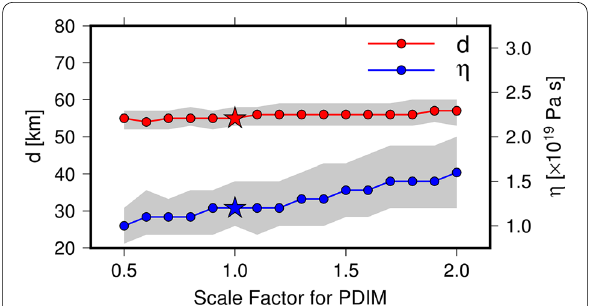
Fig. 12 Variation in the optimal values of the rheological parameters when the scale factor for PDIM is changed from 0.5 to 2.0. Red and blue lines indicate the optimal lithospheric thickness ( d ) and the upper mantle viscosity ( η ), respectively, and their error ranges are shown as the gray areas. The stars indicate the optimal values of ( d , η) when the scale factor is 1.0 (Fig.